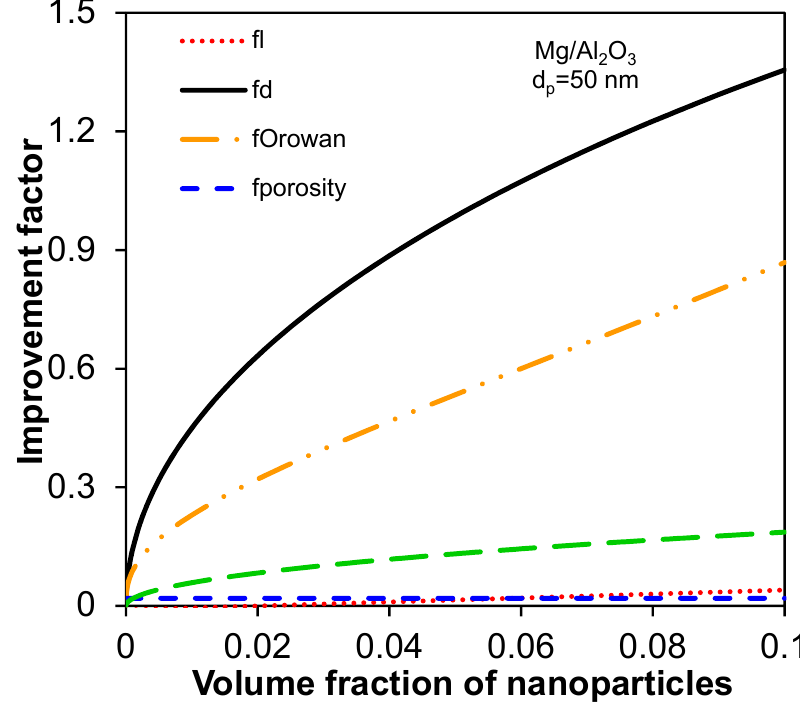
Figure 3. The improvement factors as a function of volume fraction of nanoparticles with a particle size of 50 nm and a volume fraction of 0.01 for porosity in Mg/Al 2 O 3